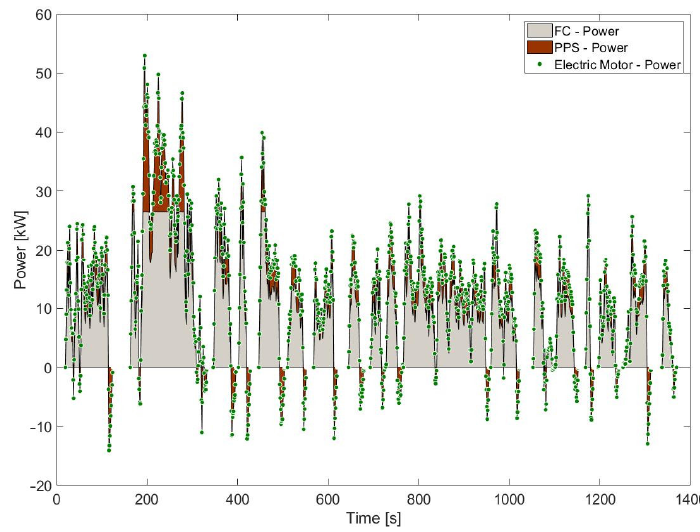
Figure 11. Power Sharing among Fuel Cell and Battery Systems.